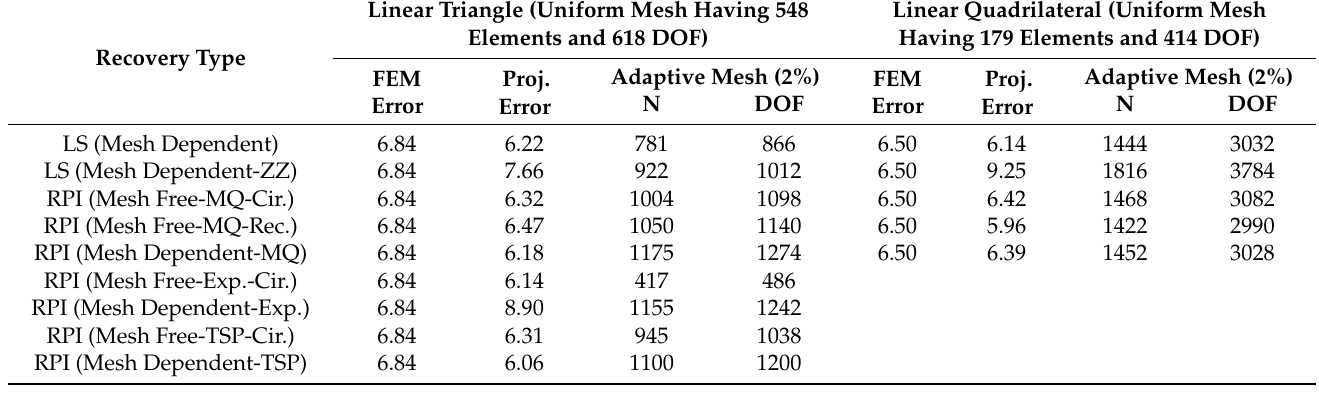
Table 14. Global errors using various recovery-based finite element analysis and number of elements (N) with DOF in adaptively improved meshes for 2% target error.